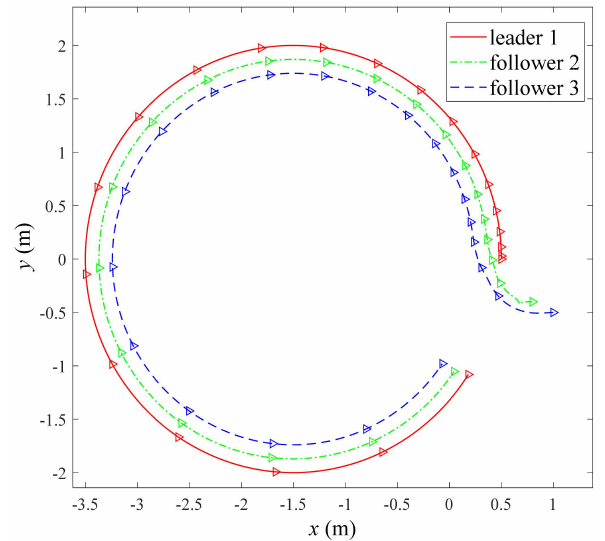
Figure 3. String formation of the platform when moving along a circular trajectory.